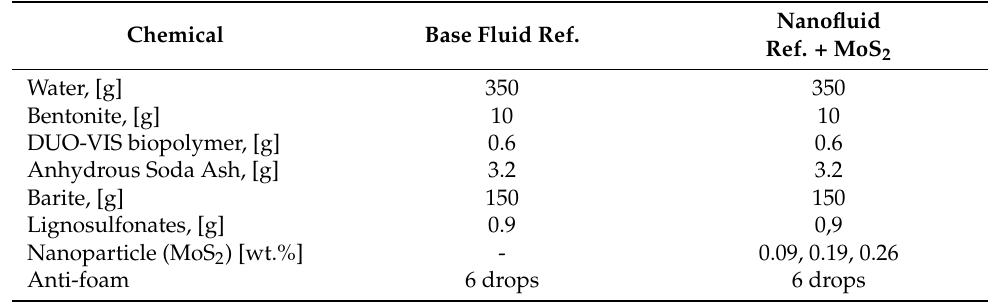
Table 1. Base fluid [Ref.] recipe without and with nanoparticle solution. Chemical Base Fluid